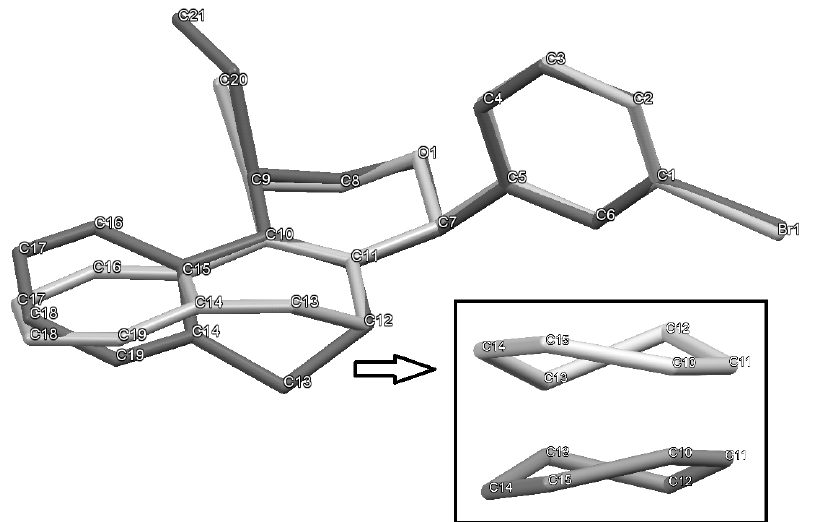
Figure 3. MERCURY view showing the superposition of equivalent conformers of 7k (light gray) and 15e (dark gray). The insert shows the rings C in a same view, which rotated 90° considering a vertical axis through center ring. The hydrogen atoms were hidden for the representation